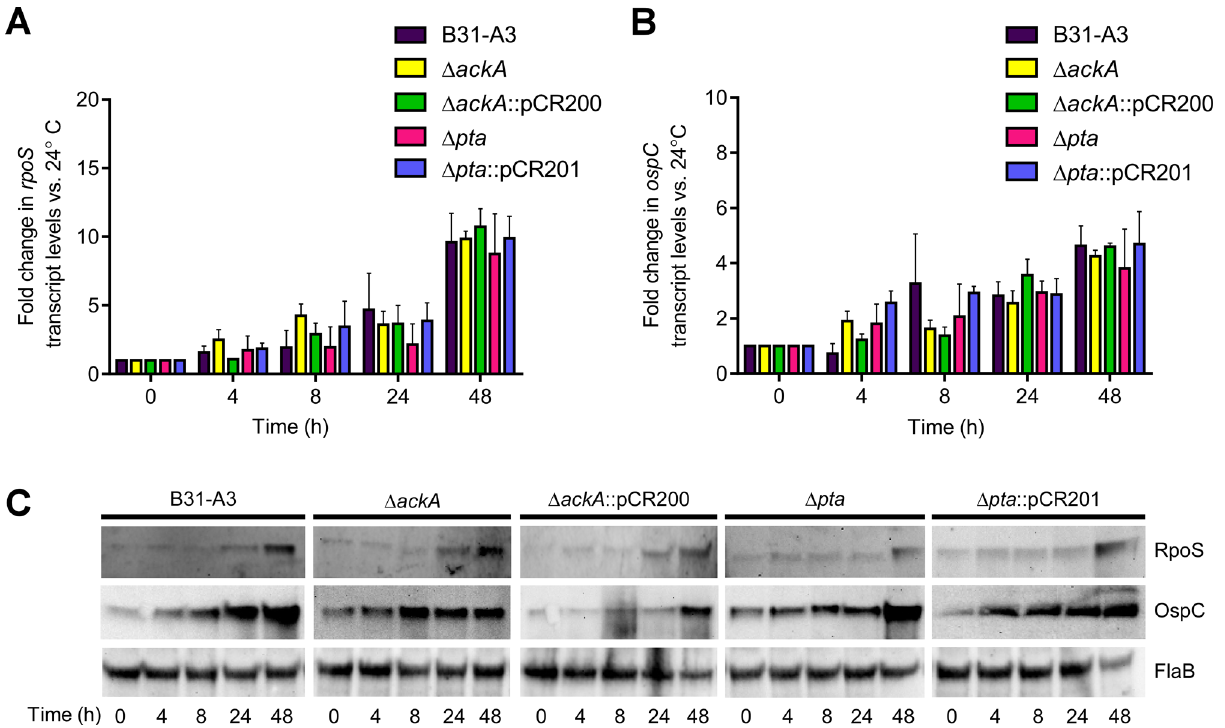
Fig 5. Quantitative RT-PCR of rpoS and ospC and immunoblot analysis of RpoS and OspC in strains B31-A3, Δ ackA , Δ pta , Δ ack ::pCR200 and Δ pta ::pCR201 after an increase in growth temperature. (A) RT-PCR analysis of rpoS and (B) ospC transcripts in B31-A3, Δ ackA , Δ ackA ::pCR200, Δ pta , and Δ pta ::pCR201, after a temperature shift from 24°C to 34°C. Samples were collected at 0, 4, 8, 24, and 48h and transcript levels were compared to expression at 24°C. (C) Immunoblot analysis of RpoS and OspC in each strain after a temperature shift and sampling at the indicated time points. Immunoblots were probed with antiserum specific for RpoS, OspC and FlaB. FlaB was included as a protein load control for each